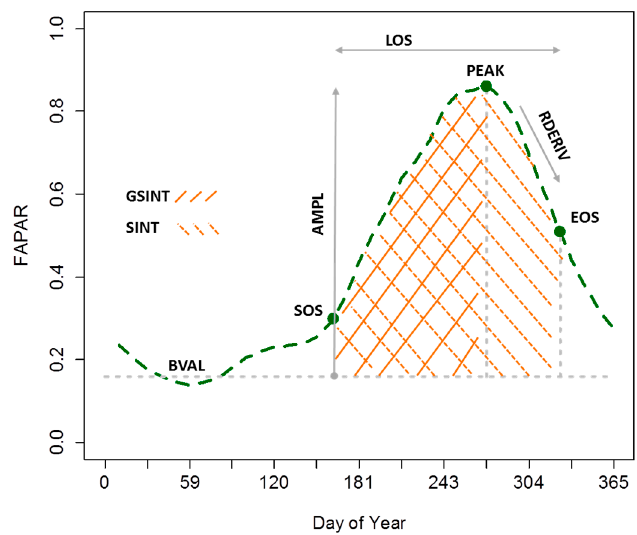
Figure 2. Seasonal FAPAR metrics considered in this study and shown for a single pixel. The base value (BVAL) represents the averaged minimum values over the annual cycle (i.e., before and after the growing season).